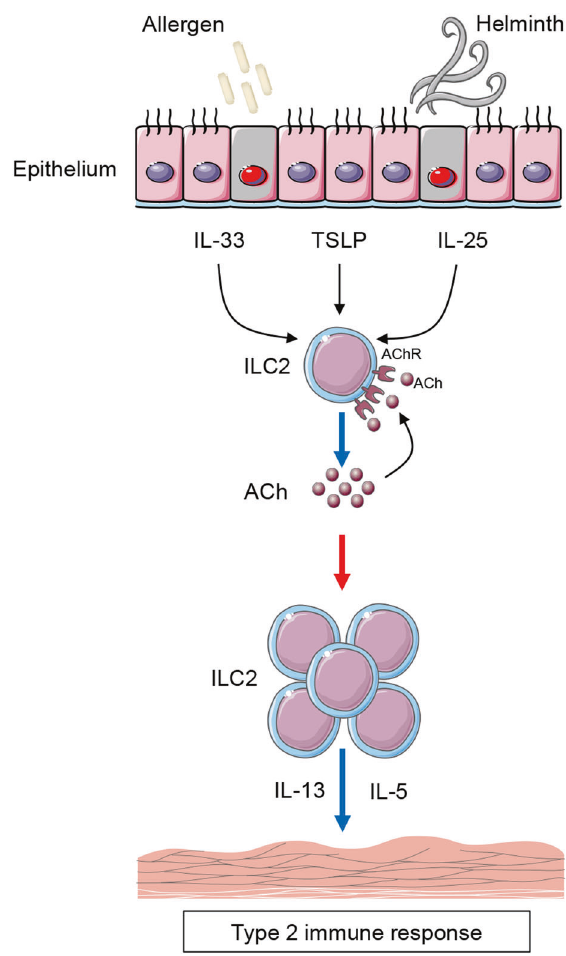
Fig. 1 Autocrine regulation of ILC2 responses mediated by ChAT-ACh pathway during helminth infection and allergen challenge. ILC2s upregulate choline acetyltransferase (ChAT) — the enzyme responsible for the biosynthesis of acetylcholine (ACh) after helminth infection or challenging with allergens or alarmin cytokines including IL-33, IL-25, and thymic stromal lymphopoietin (TSLP). ILC2s also express numerous acetylcholine receptors, which can respond to ACh derived from ILC2s to form an autocrine feedback loop. Autocrine regulation of ILC2 responses mediated by ChAT-ACh pathway is indispensable for ILC2 effector function through manipulating their proliferation